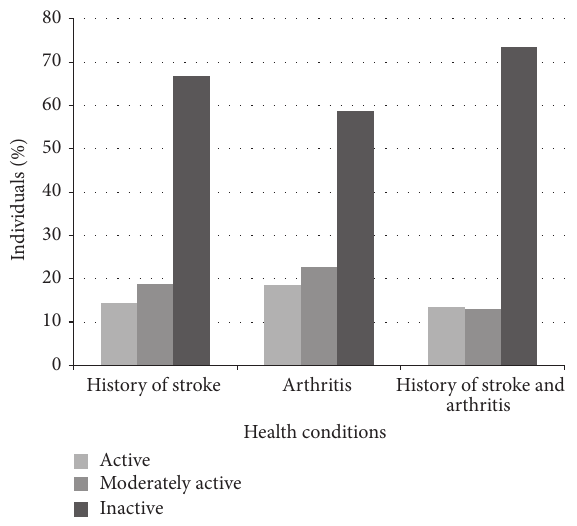
Figure 1: Physical activity levels within CCHS participants with stroke, arthritis, and both conditions